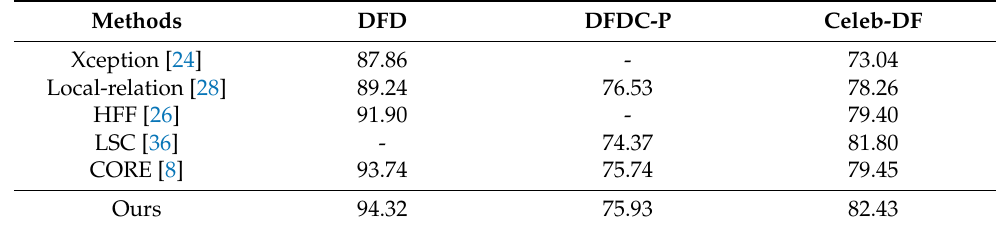
Table 3. The cross-dataset evaluation results for DFD, DFDC-P, and Celeb-DF datasets (AUC%).